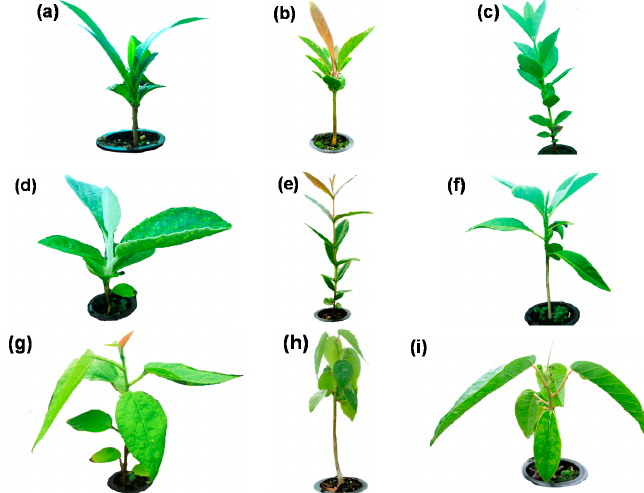
Figure 1. Tree seedling species with different mean leaf angles used in this study. ( a ) Genipa americana L. (58 ◦ ), ( b ) Magnolia ovata (A.St.-Hil.) Spreng. (57 ◦ ), ( c ) Psidium cattleyanum Sabine (55 ◦ ), ( d ) Moquiniastrum polymorphum (Less.) G. Sancho (42 ◦ ), ( e ) Lafoensia pacari A.St.-Hil. (38 ◦ ), ( f ) Esenbeckia leiocarpa Engl. (31 ◦ ), ( g ) Guazuma ulmifolia Lam. ( − 14 ◦ ), ( h ) Heliocarpus popayanensis Kunth ( − 54 ◦ ) and, ( i ) Croton floribundus Spreng. ( − 56 ◦